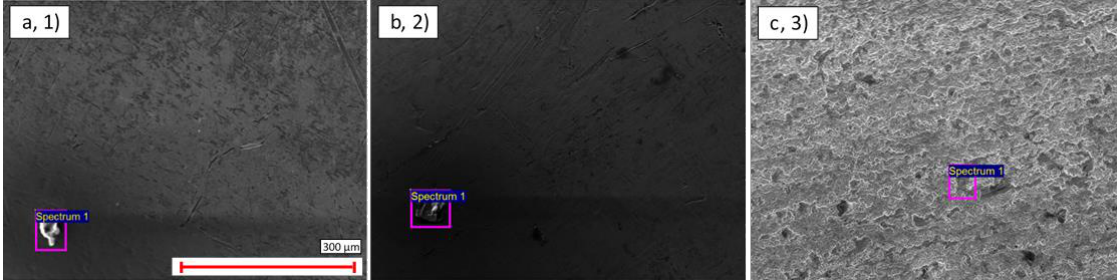
Figure 4. SEM image of contamination on the external surface of: ( a ) Cu Ni thin-walled pipe (1); ( b ) SS thick-walled pipe (2); ( c ) Ti Ni thin-walled pipe (3).